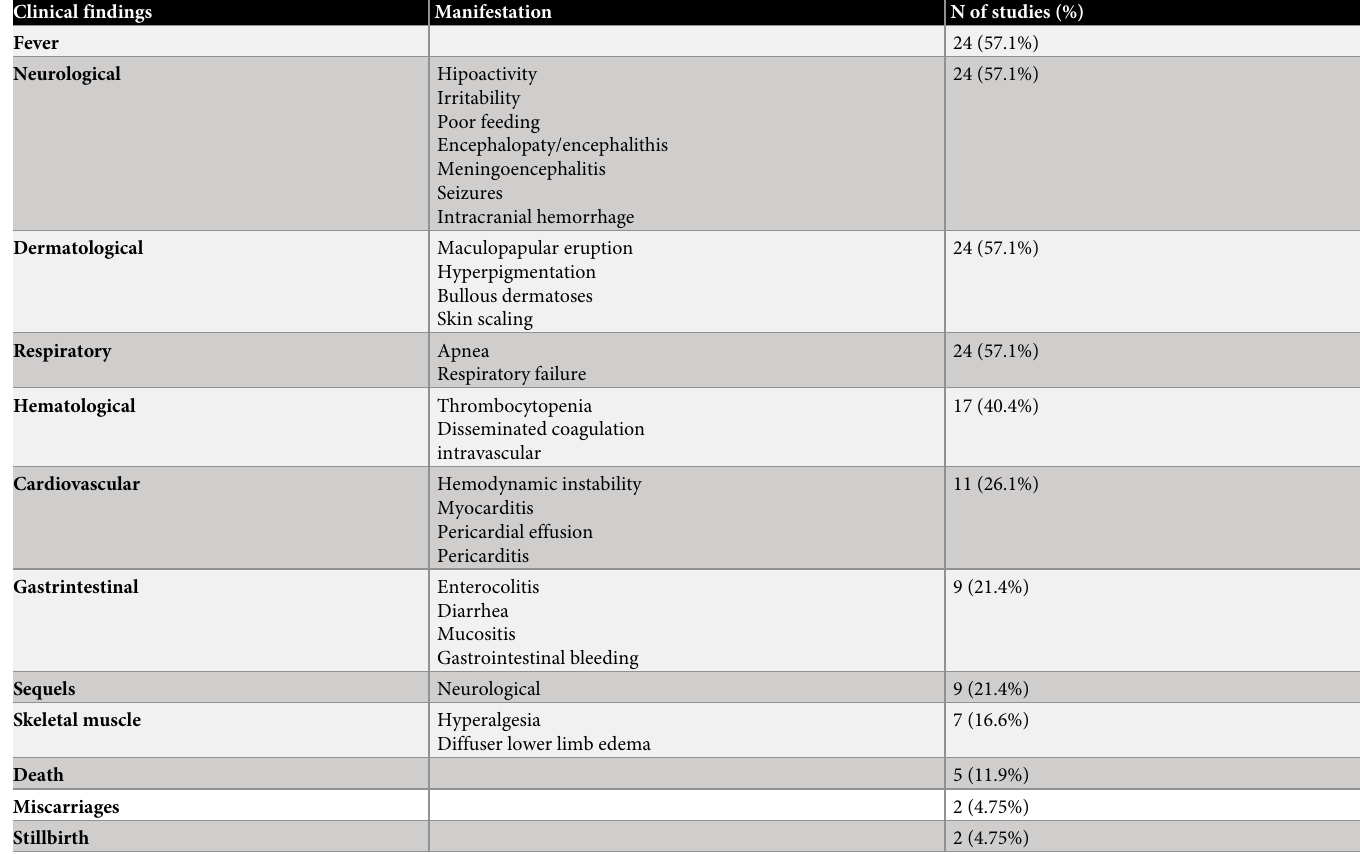
Table 3. Characteristics of 42 mother-to-child congenital chikungunya